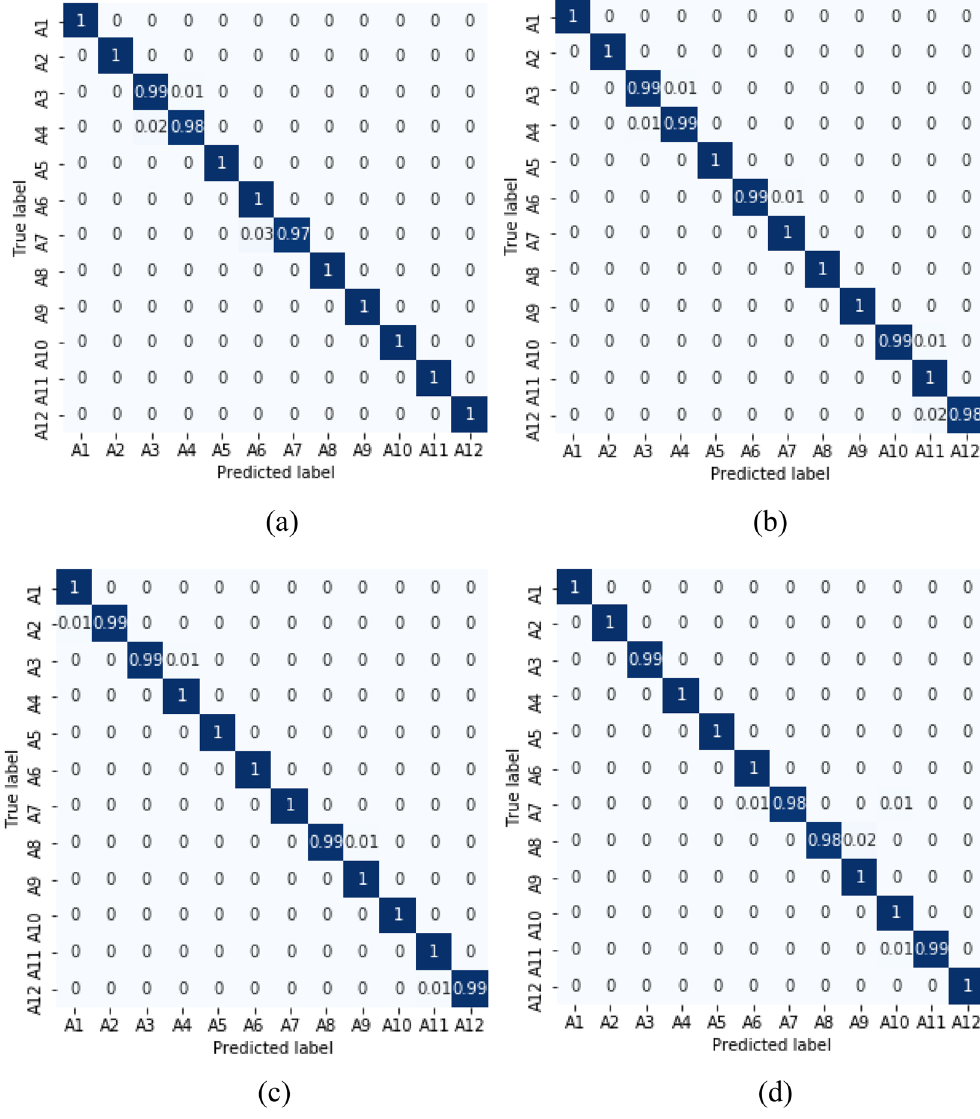
Figure 9. Confusion matrices of fold 7–10 from (g) to (j) using